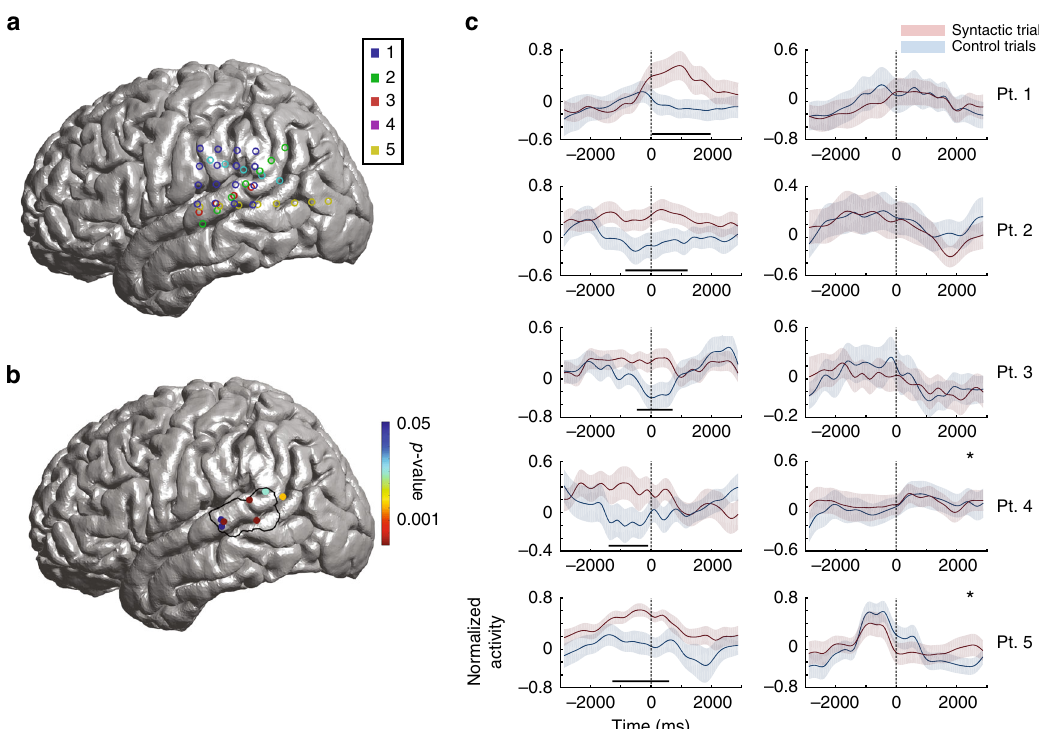
Fig. 4 Neural responses during the production of functional morphemes. a Neural recording locations are color coded by participant. The recording grids were centered along the P-STG and were con fi gured to match the available craniotomy openings. b Recording sites that demonstrated signi fi cant modulation during syntactic in fl ection compared to the control condition. The black outline here delineates the region identi fi ed by stimulation testing to produce a selective de fi cit on the syntactic condition. Only sites that displayed signi fi cant modulation are displayed. The degree of signi fi cance is displayed on the right. c Local fi eld responses aligned to speech onset (time zero). Neural responses are displayed with their 95% con fi dence interval (±CI). Blue curves represent neuronal responses on control trials, whereas red curves represent neuronal responses on the syntactic condition trials. The horizontal lines represent time periods in which there was a signi fi cant divergence ( “ Methods ” ). The columns represent recording locations below (left) and above (right) the TPJ within the same individual subjects (sites close to the border are marked with an